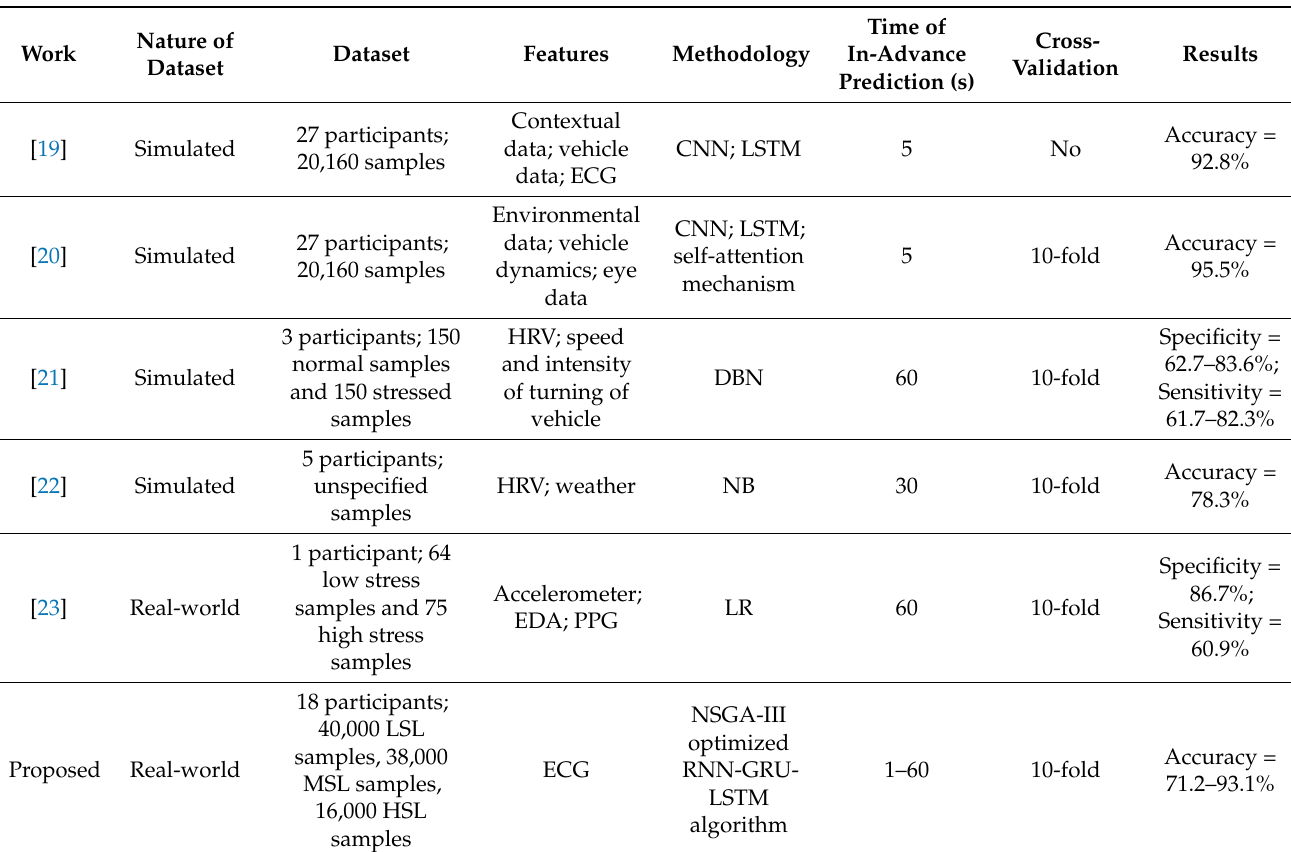
Table 7. Comparison between the proposed algorithm and existing works for driver stress